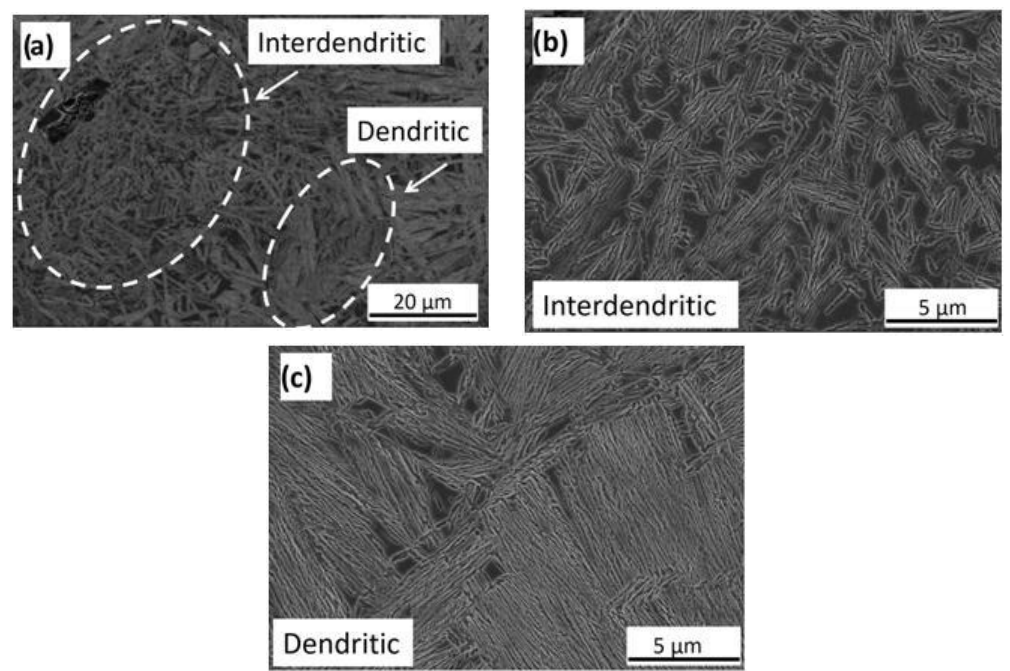
Figure 9. SEM micrographs showing: ( a ) the microstructure obtained at 280 °C for 360 min, ( b ) interdendritic and ( c ) dendritic regions. Nital 2%.